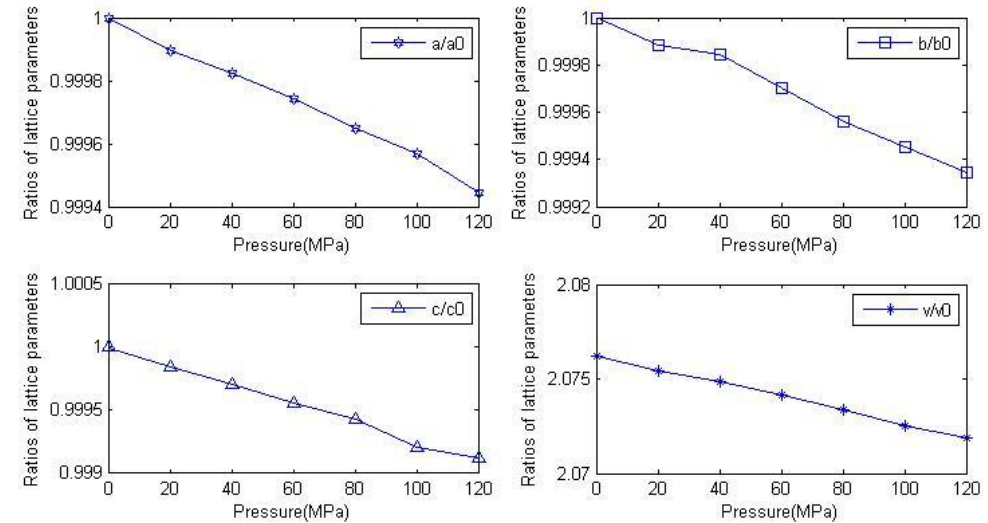
Figure 2. Relationship between lattice constants and volume ratio of anhydrite crystals and pressure.